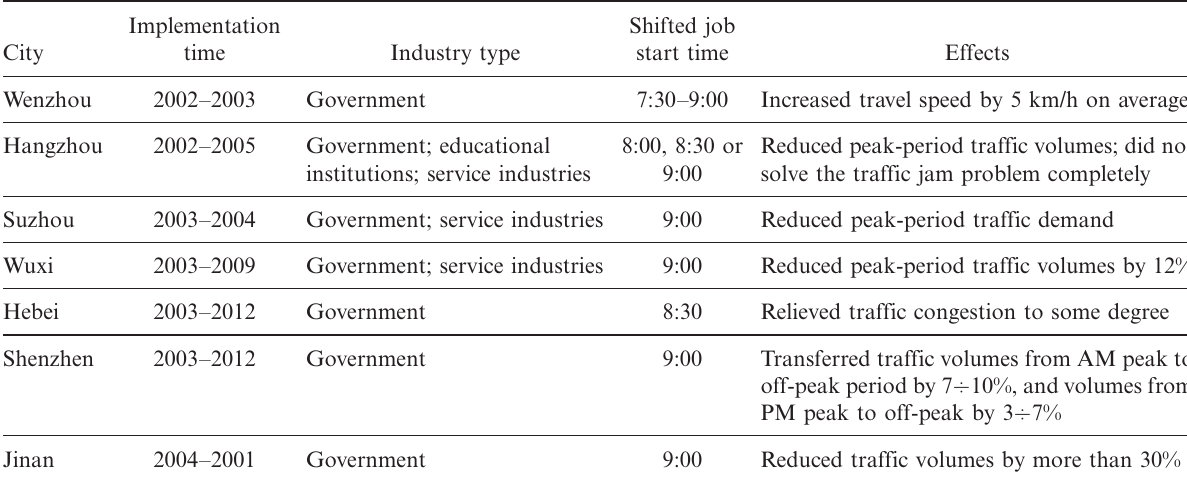
Table 1. The cases of staggered shifts in